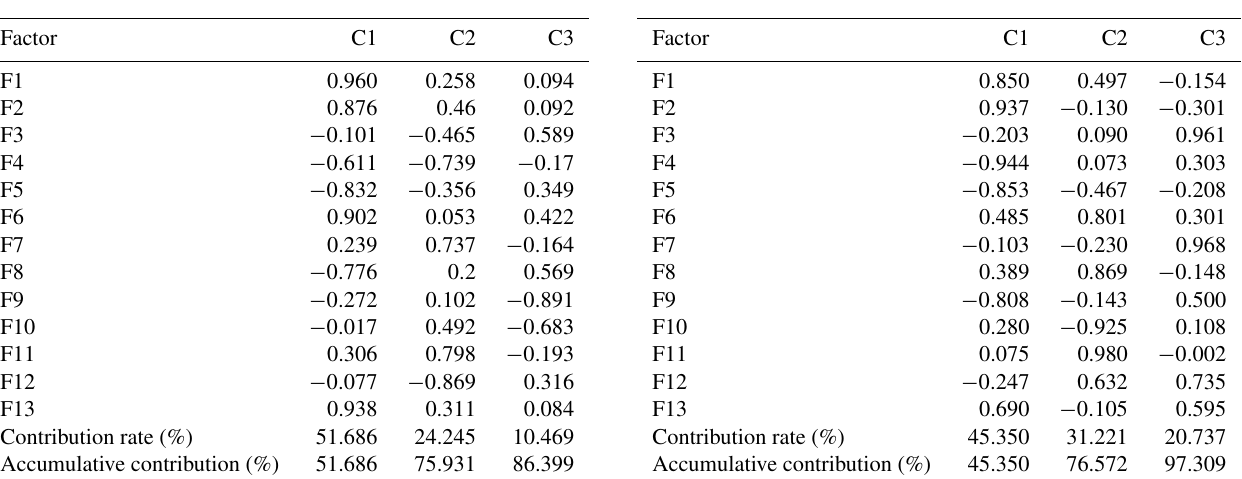
Table 7. The factor-loading matrix after rotation and contribution ratios for the second category.